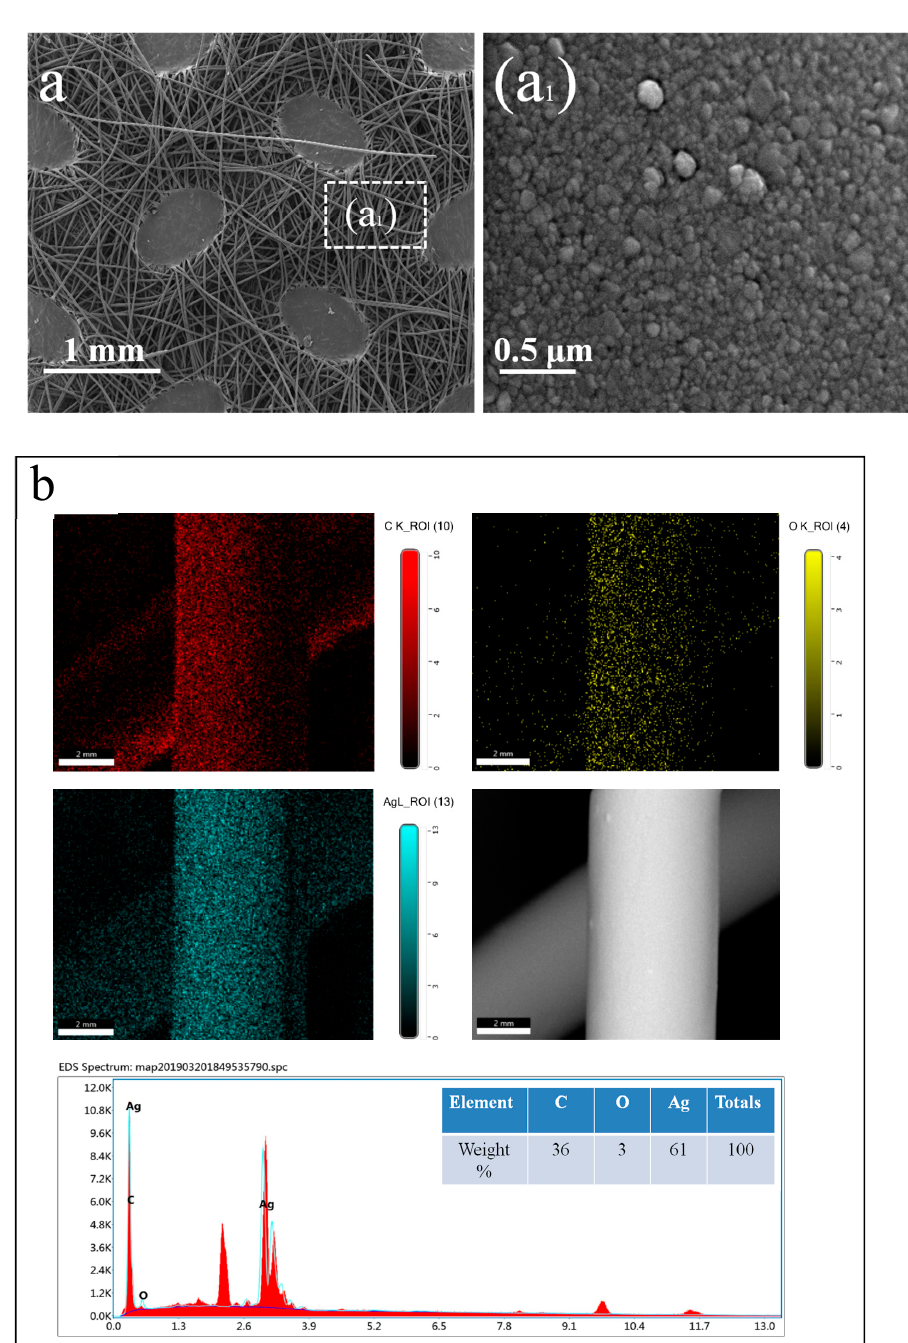
Figure 3. Surface morphology and chemical composition of Ag sputtered nonwoven fabric. ( a ) SEM images (50 × & 40,000 × ) of Ag sputtered PP nonwoven fabric; ( b ) the elemental mapping image of the sputtered fabric.